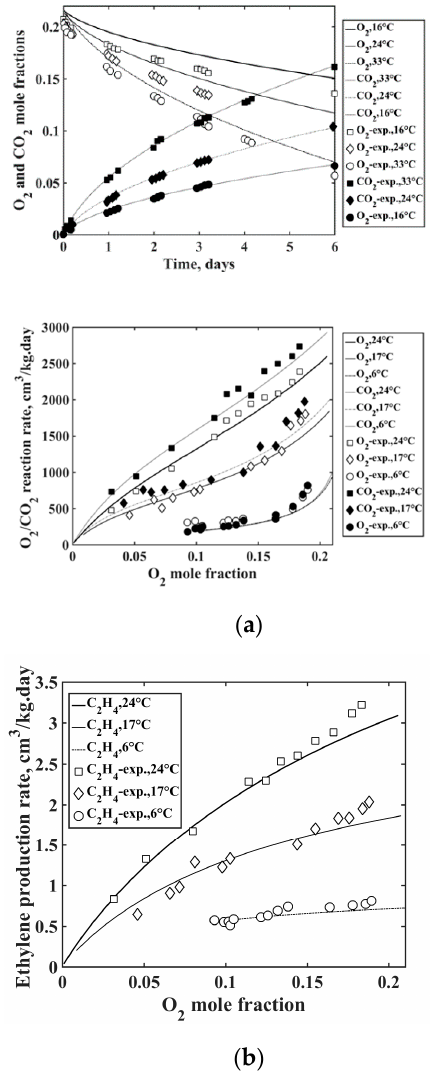
Figure 8. Validation of the enzyme kinetics implementation to the CFD model for tomatoes and avocadoes. Experimental data are obtained from Castellanos et al. [7,26]. ( a ) Tomatoes, ( b ) Avocadoes.